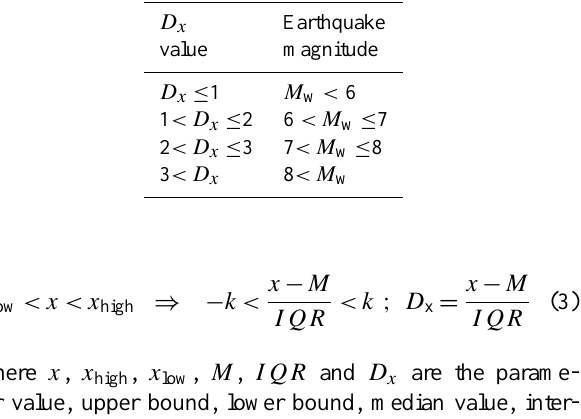
Table 1. Estimation of the earthquake magnitude (Akhoondzadeh, 2011). D